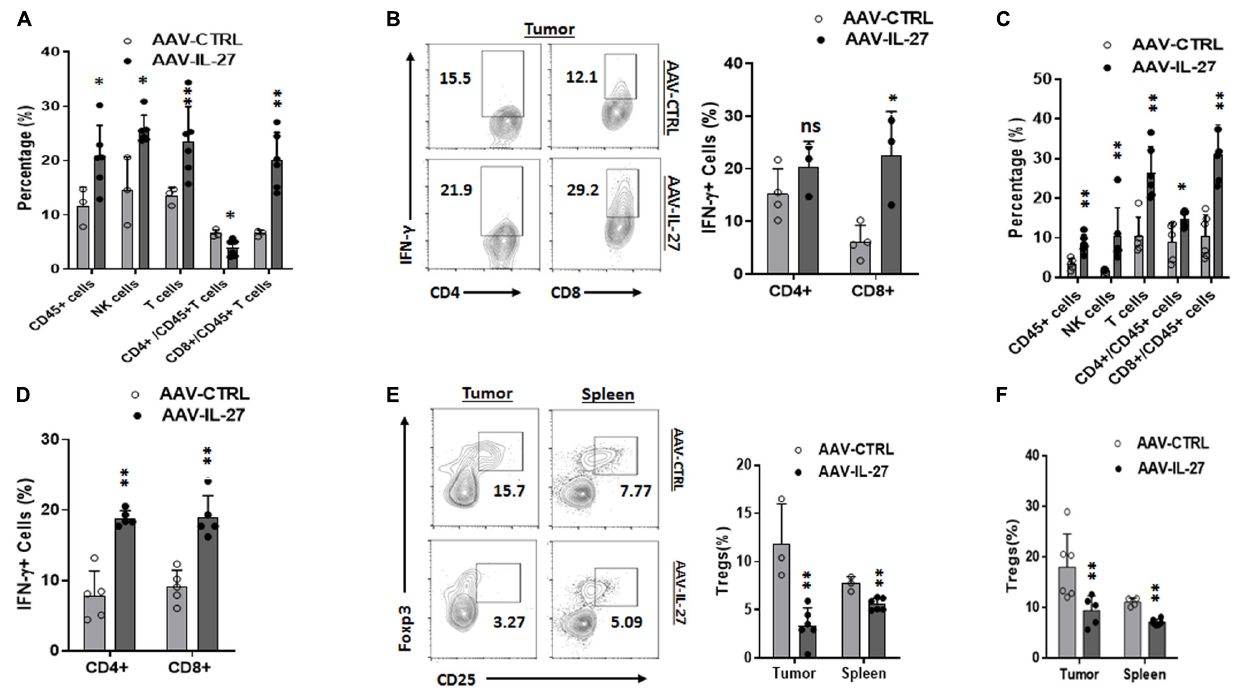
FIGURE 3 | Intra-tumoral injection of AAV–IL-27 alters tumor immune microenvironment. (A,B) B16.F10 cells (2 × 10 5 ) were injected into C57BL/6 mice s.c. Seven days later, mice were treated with AAV-IL-27 or AAV-ctrl virus intra-tumorally at a dose of 2 × 10 11 DRP/mouse. Mice were sacrificed on day 21, and populations of tumor infiltrating lymphocytes (A) and IFN- γ production by tumor infiltrating T cells (B) were analyzed by flow cytometry. (C,D) J558 cells (5 × 10 6 ) were injected into BALB/c mice s.c. Seven days later, mice were treated with AAV-IL-27 or AAV-ctrl virus intra-tumorally at a dose of 5 × 10 10 DRP/mouse, and mice were sacrificed on day 21, and populations of tumor infiltrating lymphocytes (C) and IFN- γ production by tumor infiltrating T cells (D) were analyzed by flow cytometry. Data are expressed as Mean ± SD and represent 3–5 experiments with similar results. ns: no significant difference; * P < 0.05, ** P < 0.01, *** P < 0.001 by One-way ANOVA. (E,F) CD4 + CD25 + FoxP3 + Tregs in tumors and spleens in mice bearing B16 (E) or J558 tumors (F) . B16 and J558 tumor establishment and treatment conditions were the same as described above (A–D) . Mononuclear cells from tumors and spleens were analyzed by flow cytometry. ** P < 0.01 by One-way